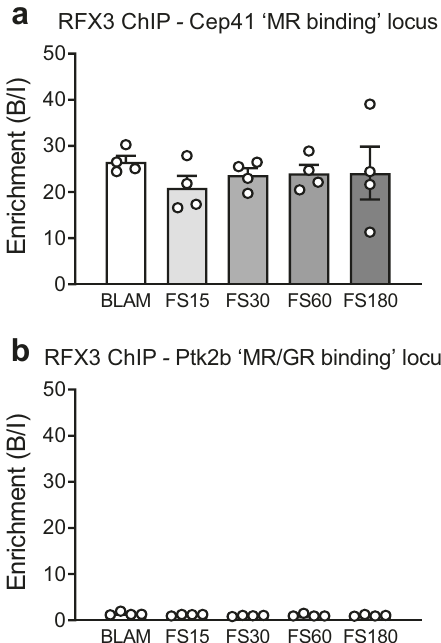
Fig. 9 RFX3 ChIP-qPCR analysis. RFX3 ChIP-qPCR analysis was conducted on Cep41 ( a ) and Ptk2b ( b ) using hippocampal chromatin of rats killed under BLAM conditions or at different times after FS. qPCR was conducted using the same DNA primers as in Supplementary Fig. 7 & Supplementary Table 2. The graphs show mean enrichment ((Bound/Input (B/I); mean ± SEM) of RFX3 binding to the genes Cep41 ( a ; n = 4 biologically independent samples) and Ptk2b ( b ; n = 4 biologically independent samples). Statistical analysis: Oneway ANOVA: ( a ) F(4,15) = 0.4308, p = 0.7843; ( b ) F(4,15) = 2, p = 0.1230. Source data are provided in the Source Data